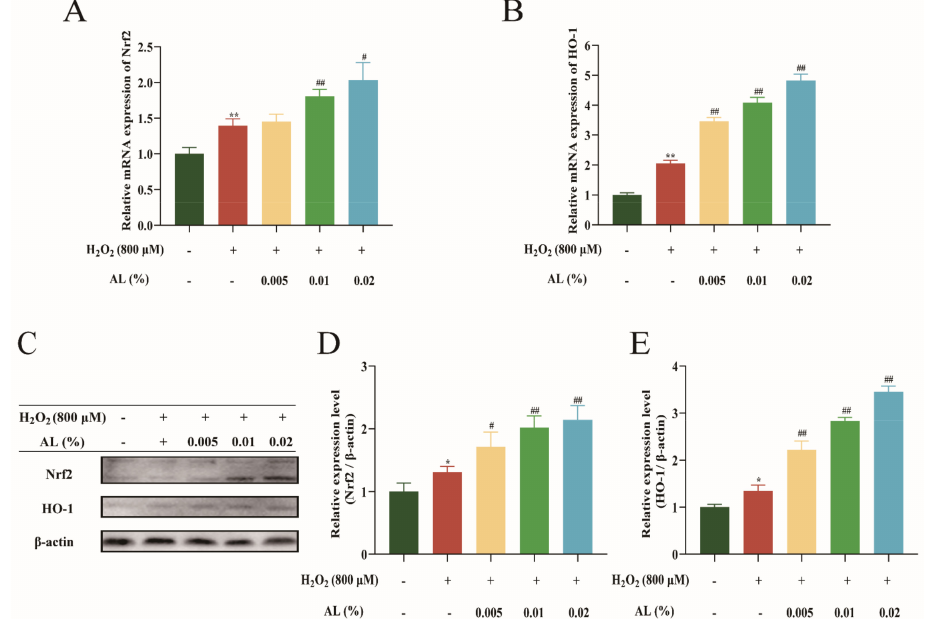
Figure 8. AL reduced H 2 O 2 -induced oxidative stress by promoting Nrf2/HO-1 in HaCaT cells. Relative mRNA expression of Nrf2 ( A ) and HO-1 ( B ) were detected in HaCaT cells via RT-qPCR. ( C ) Protein bands of Nrf2 and HO − 1 using Western blotting; protein quantification assay of Nrf2 ( D ), HO-1 ( E ) using ImageJ software. Results are expressed as means ± SDs of three independent experiments. ** p < 0.01, * p < 0.05 compared to the normal group (no treatment); ## p < 0.01, # p < 0.05 compared with the H 2 O 2 group. One-way ANOVA was used to evaluate